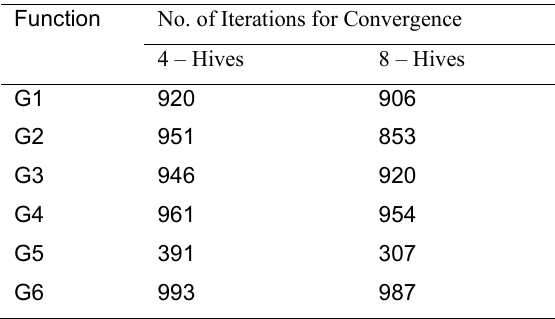
Table 7. Convergence of 4 hives vs. 8 hives Function No. of Iterations for